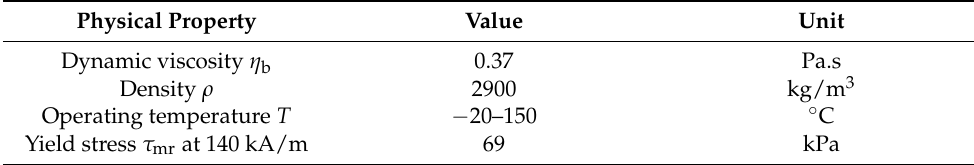
Table 1. Physical properties of the magnetorheological fluid AMT-SMARTEC + [15].